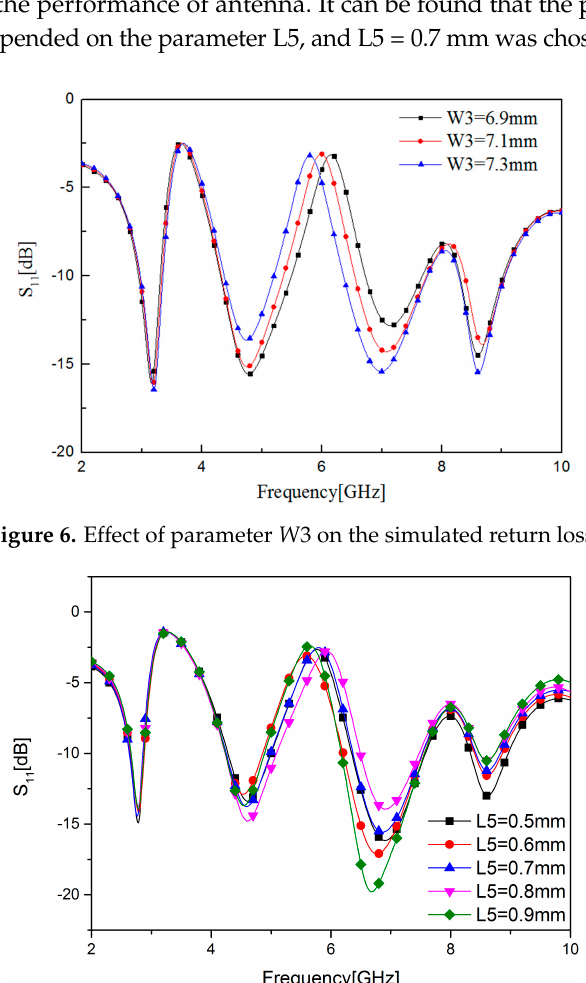
Figure 7. Effect of parameter L 5 on the simulated return loss.